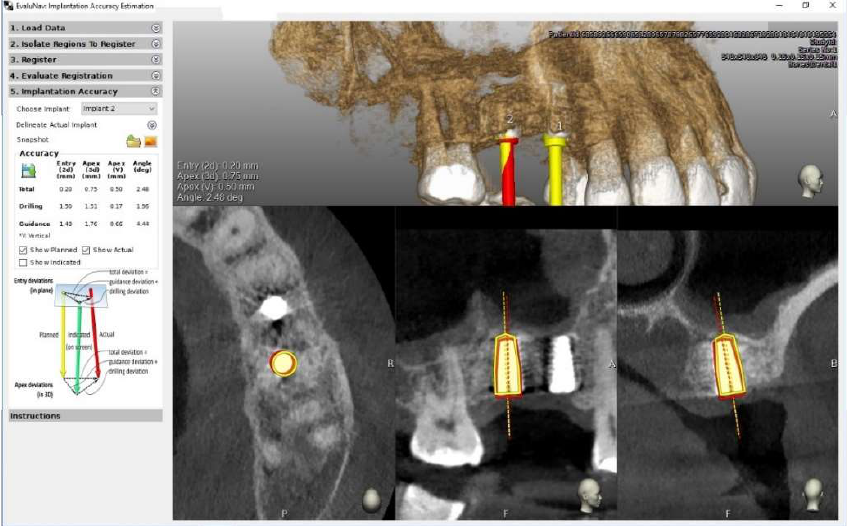
Figure 5. Comparison between planning (yellow) and actual implant position (red) based on pre-operative and post-operative CBCT scans.